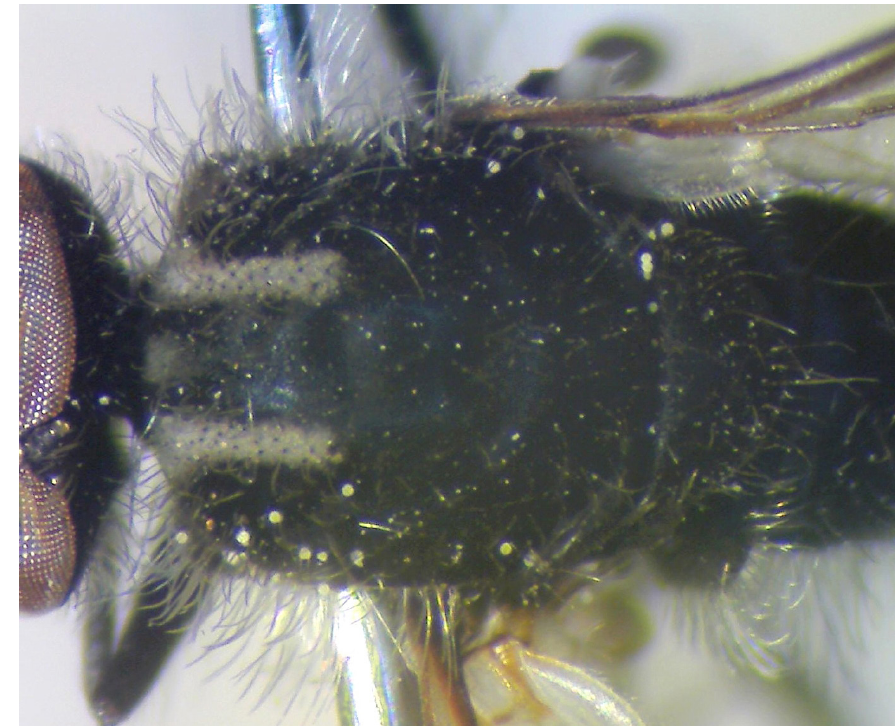
Fig. 9. Protypusia ornata (Engel, 1932) gen. et comb. nov.,